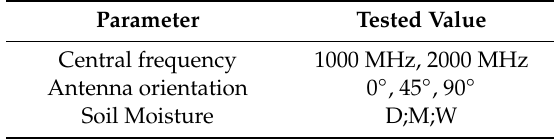
Table 2. Parameters and tested values within the data collection process.